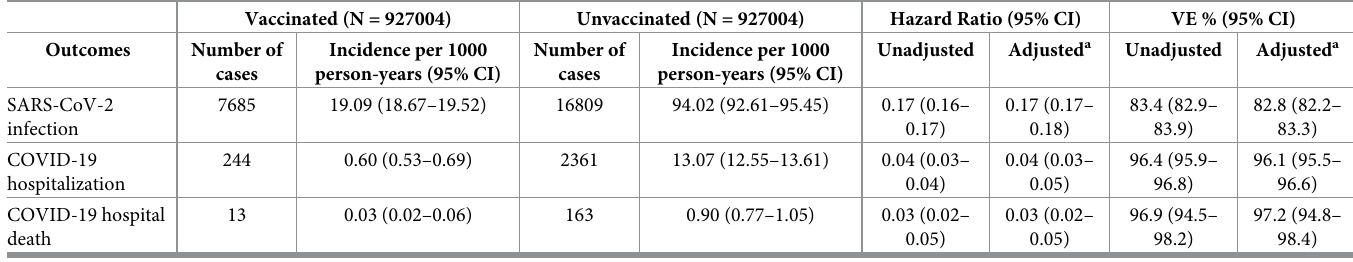
Table 2. Incidence rates, hazard ratios, and vaccine effectiveness of 2 doses of mRNA-1273 in preventing SARS-CoV-2 infection, and COVID-19 hospitalization and hospital